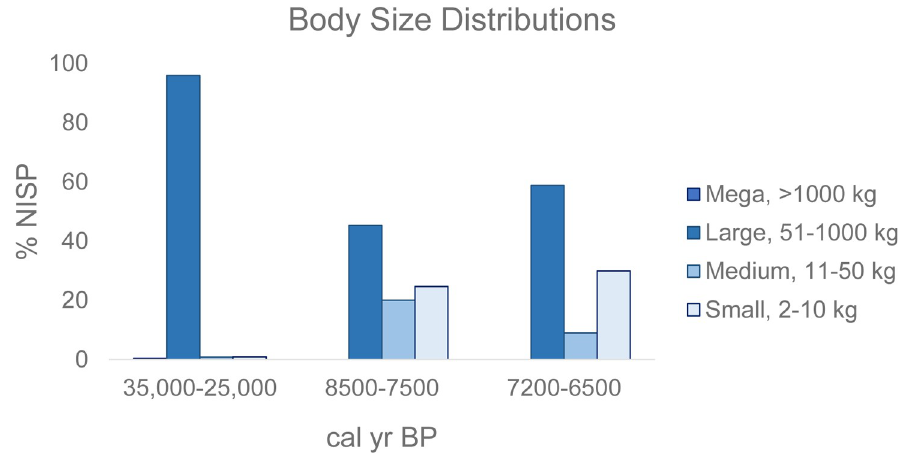
Fig 11. Relative frequencies of fauna across time periods according to